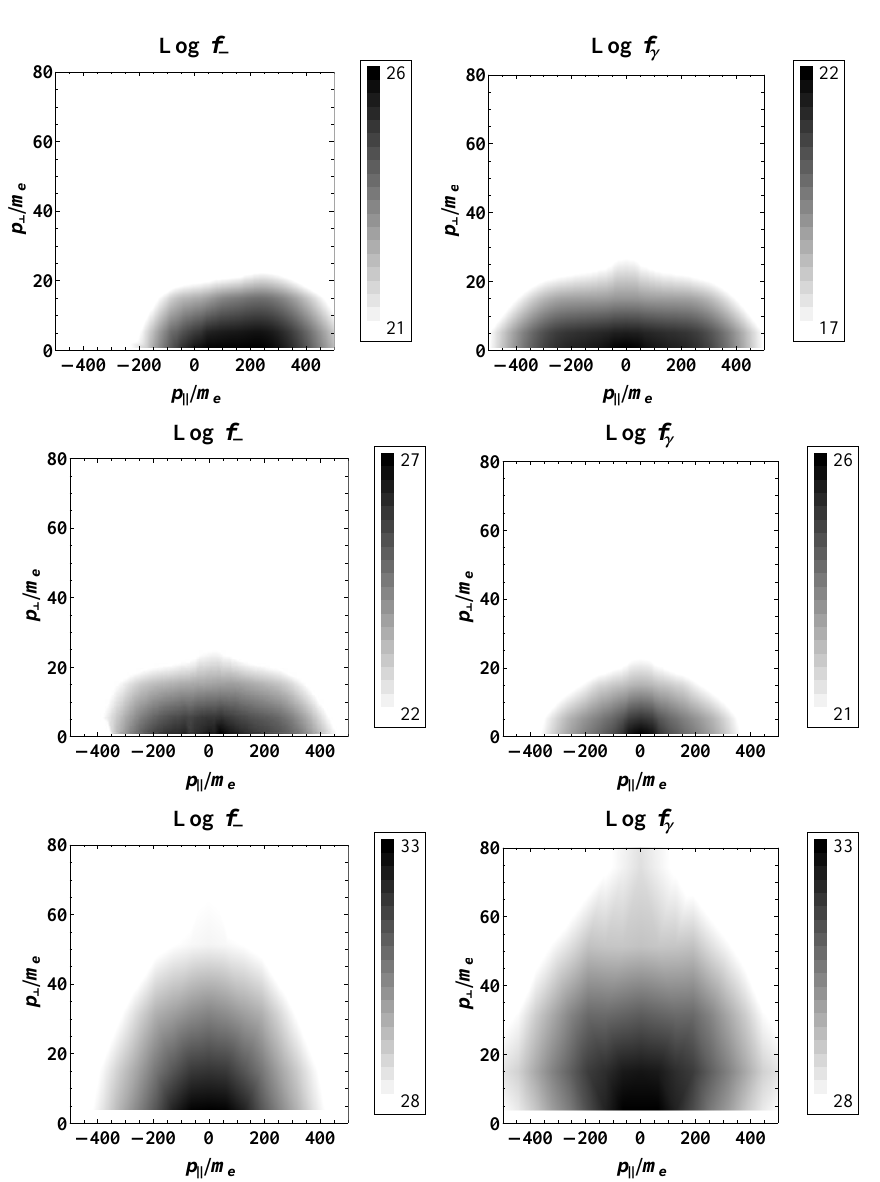
Figure 12.4 Phase space distributions of electrons (left column) and initial condition E 0 = 100 E c . Top: 2.3 photons (right column) for the initial condition E 0 = 100 E c . Top: 2 . 3 10 2 t c , middle: 2 . 3 · c 2013, with permission from Elsevier. (cid:13)